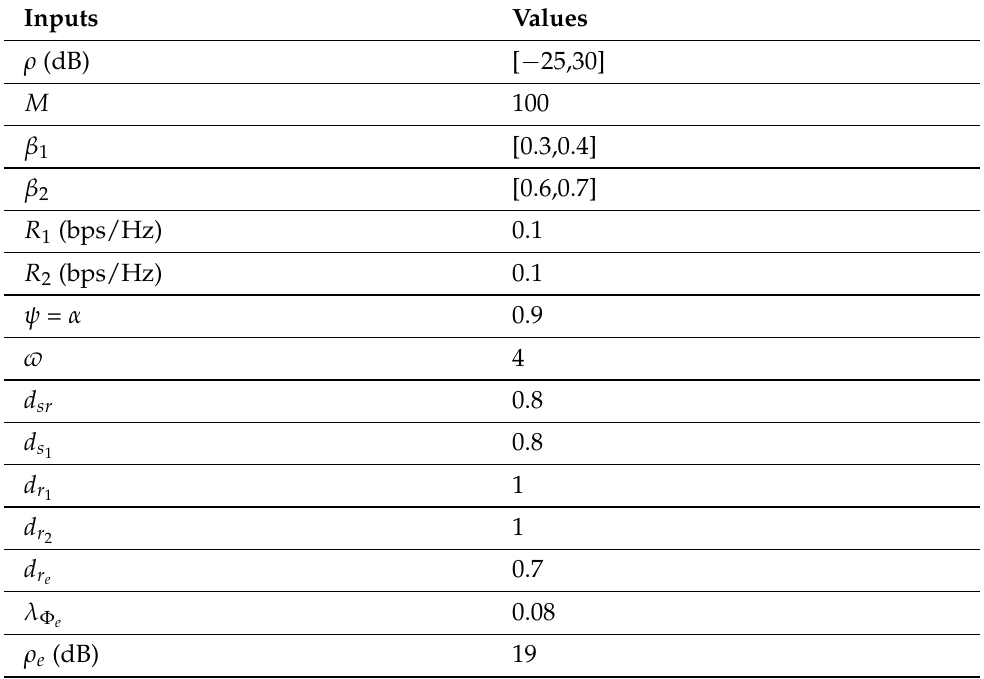
Figure 3. The procedures of SOP prediction. Table 1. The system parameters using in DNN for training and testing